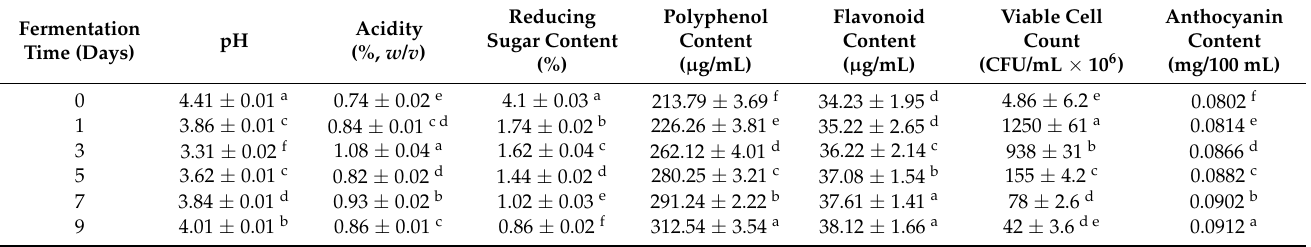
Table 3. Physicochemical properties of and polyphenol, flavonoid, and anthocyanin contents in aronia extract fermented by L. plantarum EJ2014.